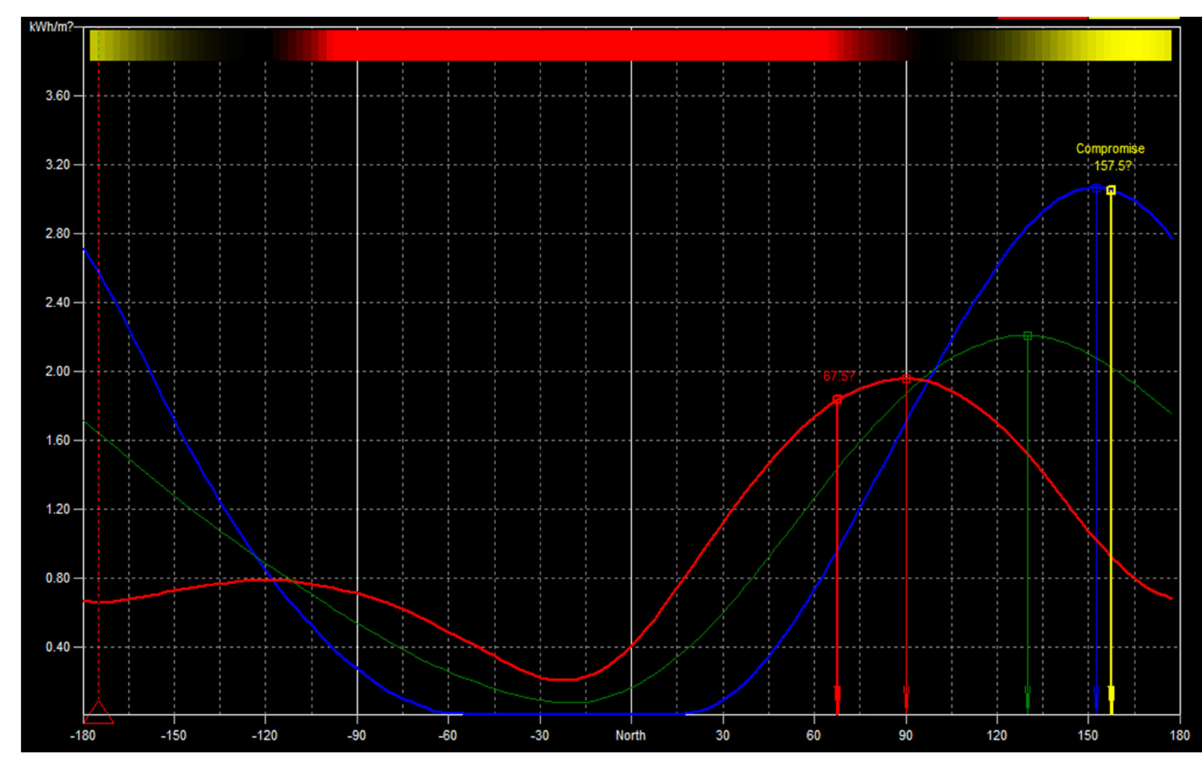
Figure 17. Optimal orientation data.